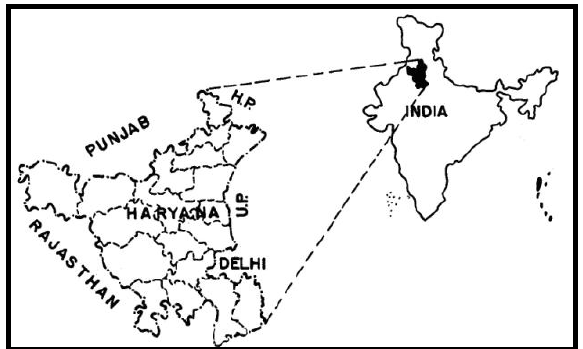
Figure 1. Location map of the study area Haryana state, which is one of the northern states of India, covers a total area of 44,212 sq kms and lies between 27 0 , 35’ to 31 0 , 55.5’ N latitude and 74 0 , 22.8’ and 77 0 35.6’ E longitudes. It is bounded by natural features as Siwaliks in North, Aravallis in South, Yamuna River in East and Ghaggar in West. The area is covered by Survey of India toposheets Nos. 44K, 44O, 44P, 53C, 53D, 53F, 53G, 53H, 54E. Except the hilly portions, most of state lies between 200 to 300 meters above mean sea level.